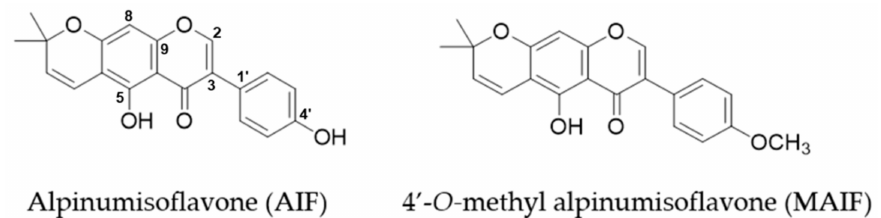
Figure 1. Structure of alpinumisoflavone and 4 (cid:48) - O -methyl alpinumisoflavone.